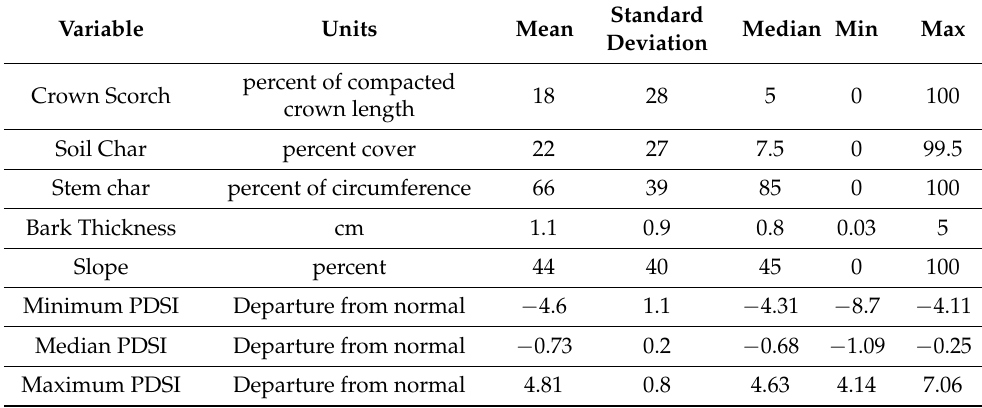
Table 2. Descriptive statistics for continuous variables used in logistic mortality